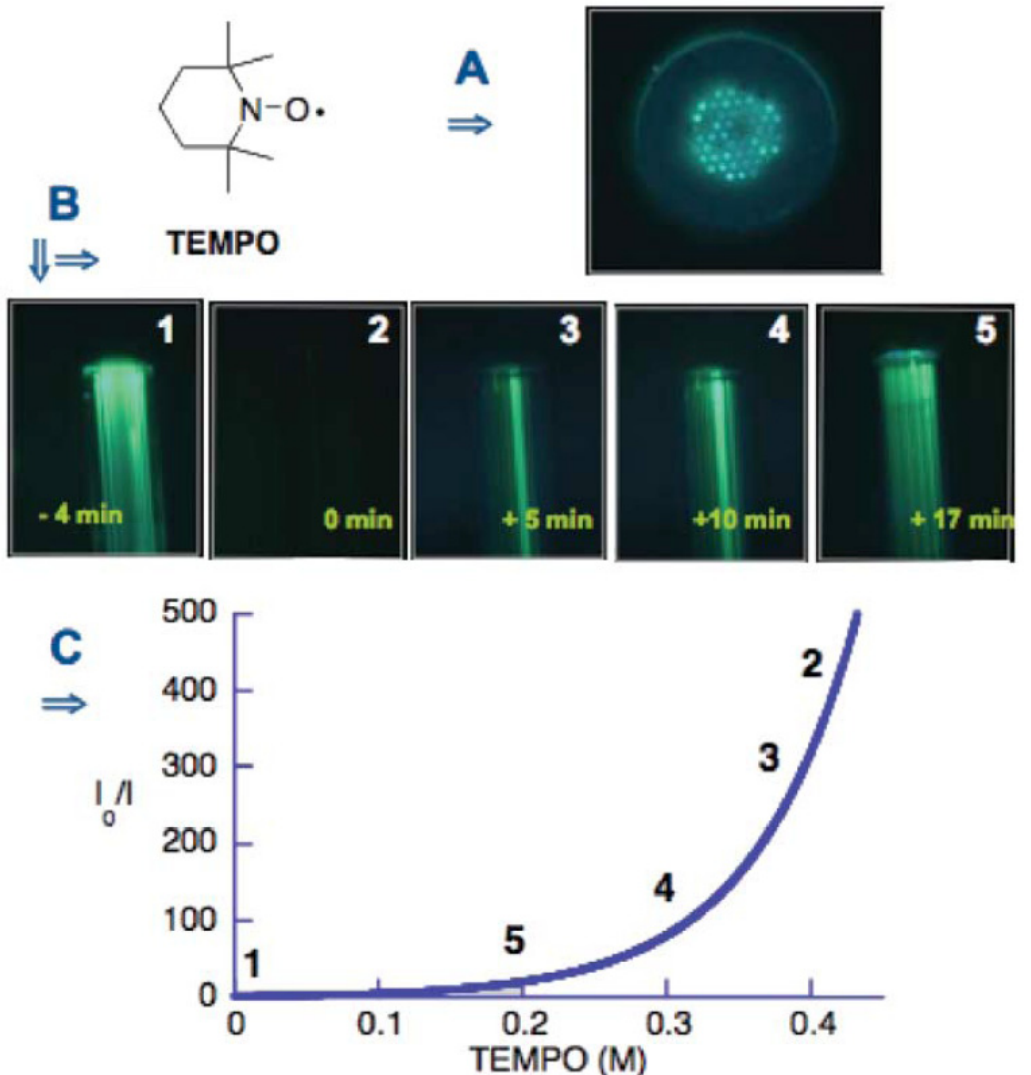
Figure 14. (A) Fluorescence photograph of the PCF end containing green QDs (2.4 nm) after addition of TEMPO and recovery. (B) Time lapse fluorescence photographs (from left to right) before adding TEMPO, immediately after, 5, 10, and 17 minutes after addition. Photographs were taken in normal (A) and transverse (B) mode. Small color differences with angle are common in photonic crystals. (C) Stern Volmer plot for quenching of green QD by TEMPO. The numbers in (C) indicate approximately the delay following addition, with ‘1’ corresponding to data before TEMPO addition. [154] - Reproduced by permission of The Royal Society of